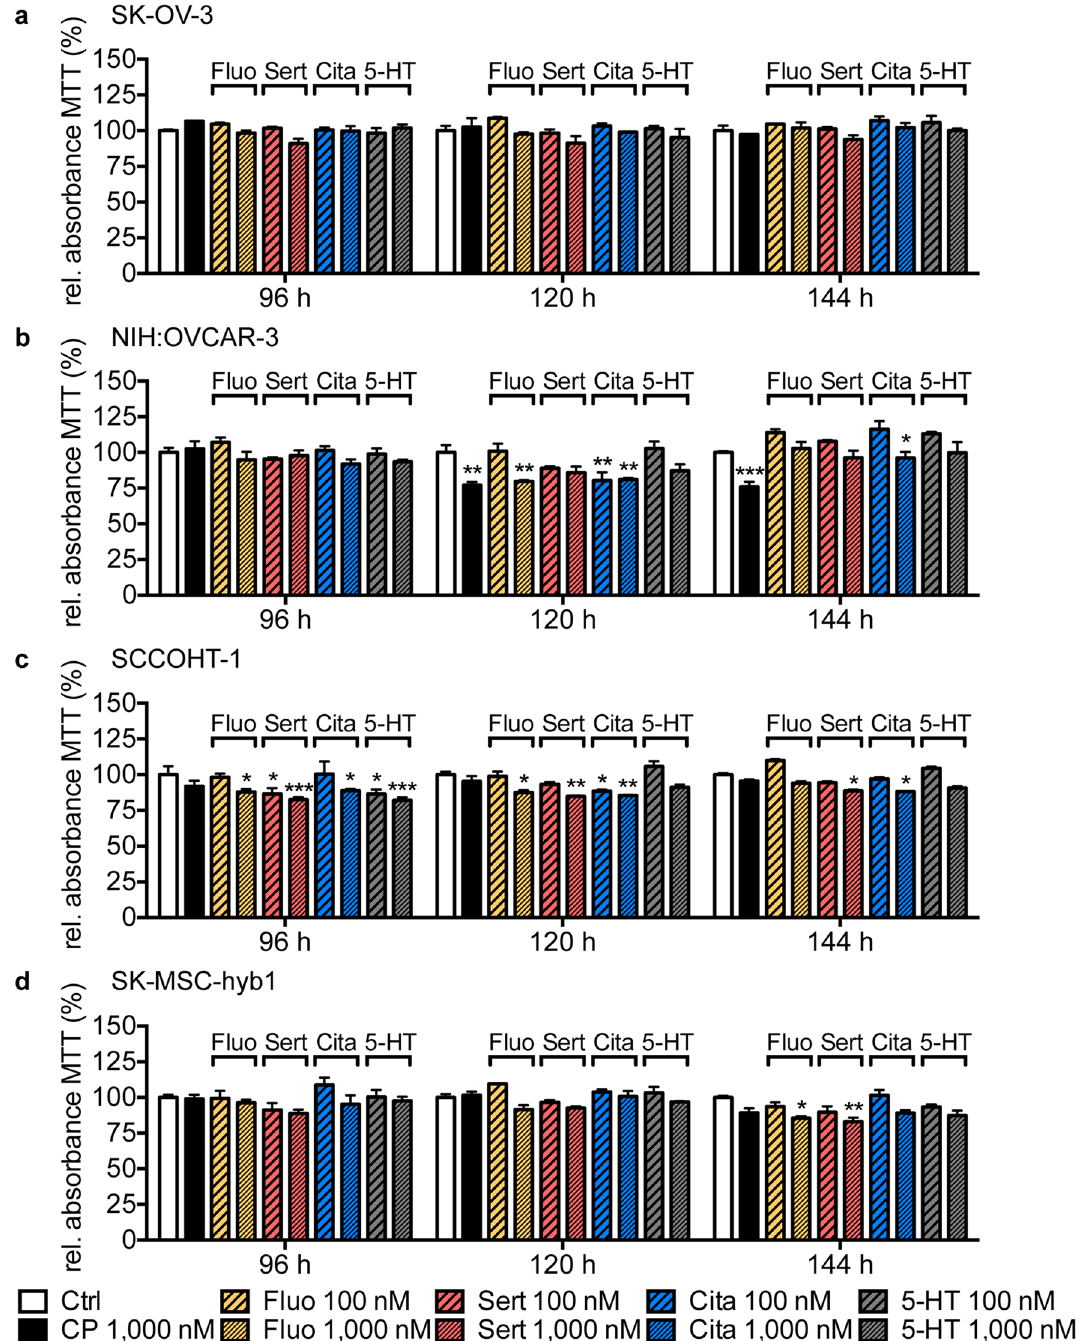
Figure 5. Effect of low-dose, long-term SSRI treatment or 5-HT exposure on ovarian cancer cell lines measured by MTT assay. Bar graphs depict relative absorbance of MTT assay of SK-OV-3 ( a ), NIH:OVCAR-3 ( b ), SCCOHT-1 ( c ) and SK-MSC-hyb1 ( d ) cells in response to exposure to 100 nM or 1,000 nM fluoxetine (Fluo; yellow), sertraline (Sert; red), citalopram (Cita; blue) or 5-HT (grey) for indicated time periods (96 h to 144 h) compared to DMSO-treated control cells (Ctrl; white) and cell receiving carboplatin (CP; 1,000 nM; black). Data are depicted as mean ± SEM and summarize n = 3 experiments. P -values were determined by two-way ANOVA followed by Dunnett’s multiple comparison-test; *** P < 0.001; ** P < 0.01; * P < 0.05 versus corresponding